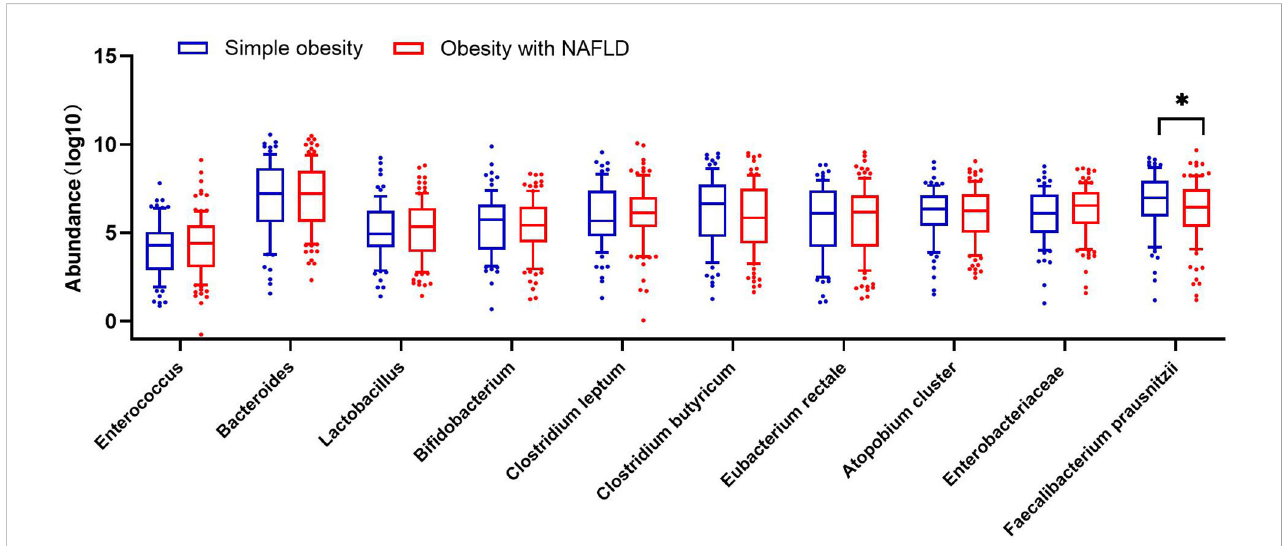
FIGURE 1 The number of dominant gut microbiota colonies in 181 patients with obesity with NAFLD and simple obesity. The symbol * represents p-value less than